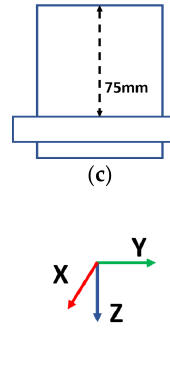
Figure 14. Illustration of the experimental setup for imaging the lab phantom using the CECAT. Figure 15. Illustration of the size and shape of the TMM particle. A 2 mm ball bearing is used as a reference. Figure 16 shows the TFM images of the phantoms with the TMM particle inside the tube. As expected, the intensity of the bright spots in the TFM images which represent the TMM particle is